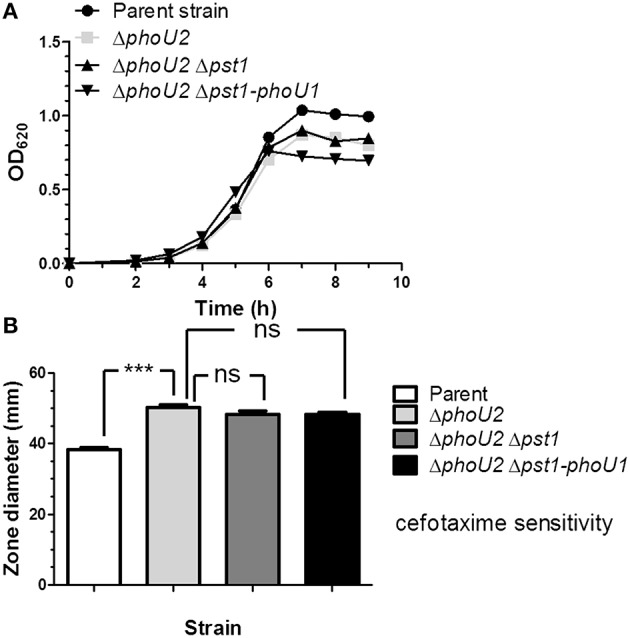
Deletion of pst1 or pst1-phoU1 in a ΔphoU2 mutant does not recover growth yield or antibiotic sensitivity. (A) Representative growth curves of encapsulated parent strain (IU1781), and ΔphoU2 (IU6375), ΔphoU2 Δpst1 (IU6664), and ΔphoU2 Δpst1-phoU1 (IU6854) mutants in BHI broth. Growth yields and rates are quantitated in Table S4. (B) Cefotaxime sensitivity assays for encapsulated parent strain (IU1781), and ΔphoU2 (IU6375), ΔphoU2 Δpst1 (IU6664), and ΔphoU2 Δpst1-phoU1 (IU6854) mutants. (n ≥ 3); ***P < 0.001. See Materials and Methods, the legend to Figure 2, and the text for additional details.